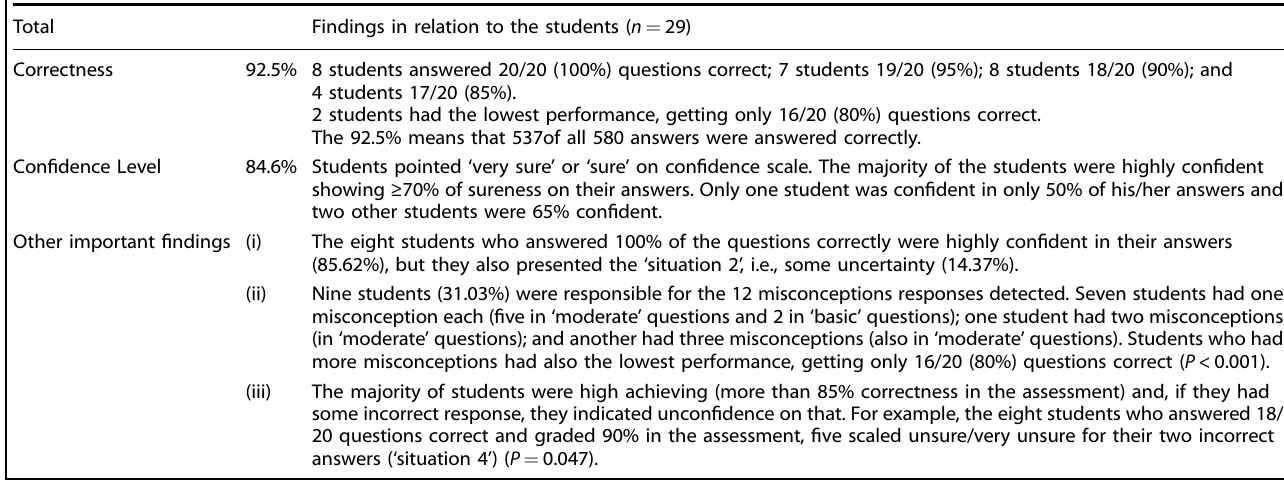
Table 1. Correctness, con fi dence level, and other important fi ndings in relation to the students. Total Findings in relation to the students ( n = 29) Correctness